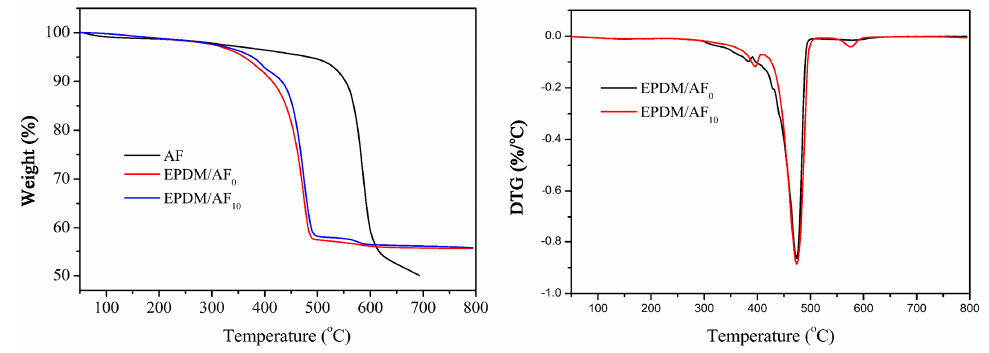
Figure 6. Thermogravimetry (TG) and differential thermogravimetry (DTG) curves of samples AF, EPDM/AF 0 and EPDM/AF 10 under N 2 . Table 9. TGA data of AF, EPDM/AF 0 and EPDM/AF 10 under N 2 .